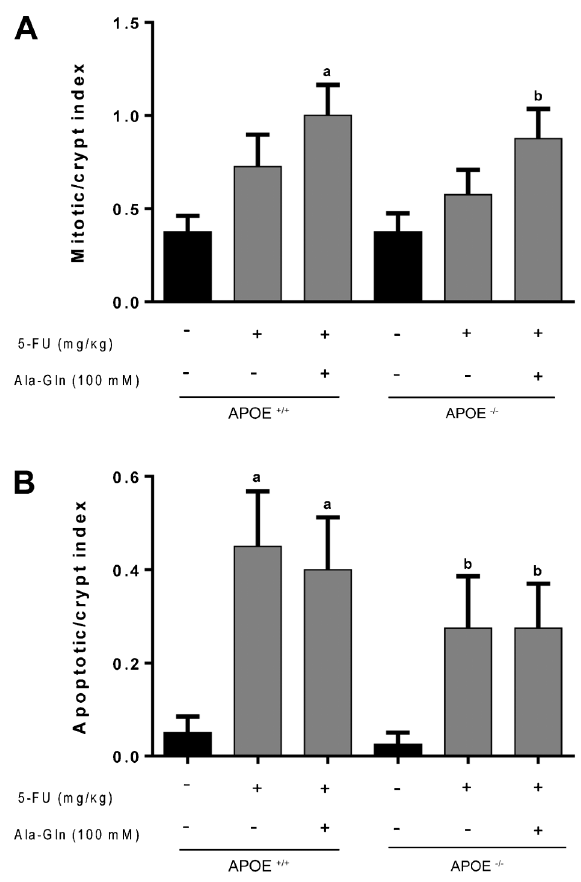
Figure 4. Mean mitotic ( A ) and apoptotic ( B ) indexes of H&E- stained ileal crypts from C57BL6J ApoE-knockout (APOE -/- ) and wild-type (APOE +/++ ) mice following 5-fluorouracil (5-FU)-induced intestinal mucositis (450 mg/kg, ip , single dose) and treated with the alanyl-glutamine (Ala-Gln, 100 mM) or phosphate buffered saline (PBS, control) via gavage. At least 10 crypts per animal were analyzed (n=4 animals/group) on the 6th day post-challenge. Data are reported as means±SEM. a P , 0.001 vs unchallenged APOE +/++ mice; b P , 0.05 vs unchallenged APOE -/- mice (one-way ANOVA and the Bonferroni test).